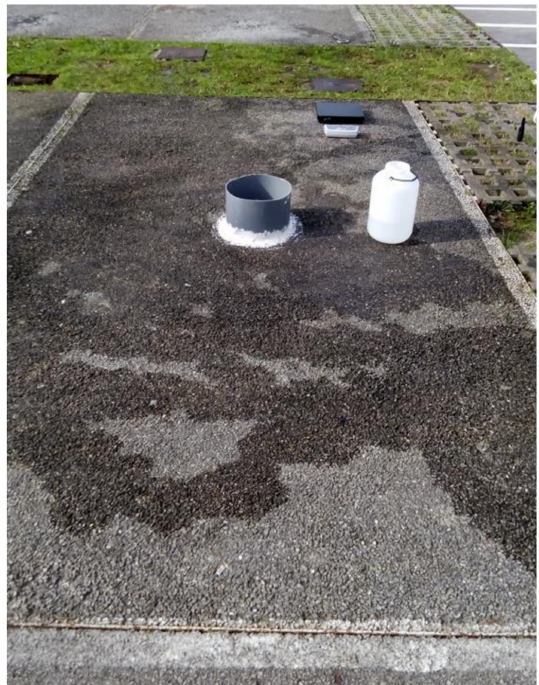
Figure 4. Preparation of the infiltration ring for the ASTM C1701/C1701M-09 test on PMPC and PA